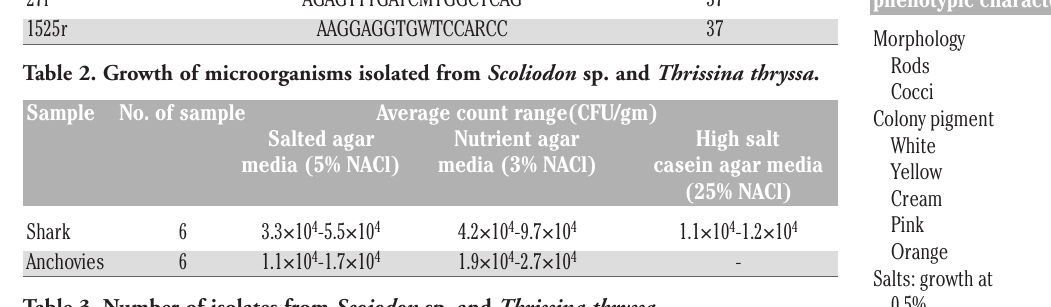
Table 3. Number of isolates from Scoiodon sp. and Thrissina thryssa. Sample